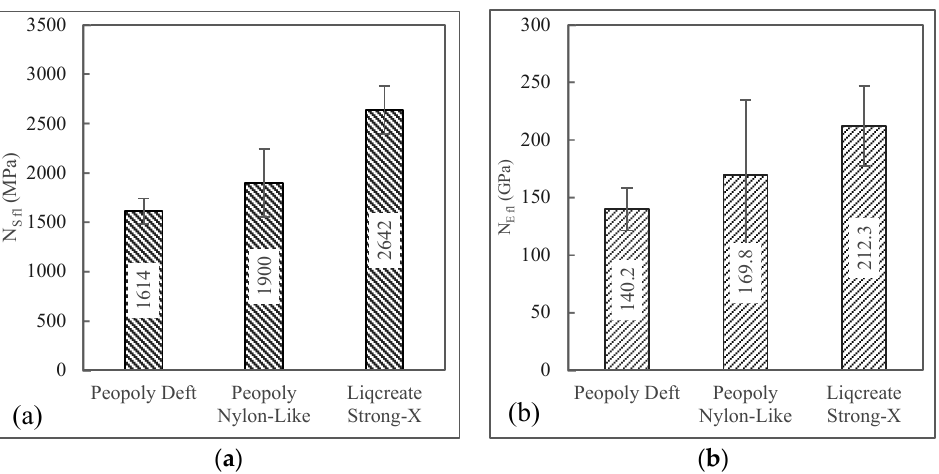
Figure 14. ( a ) Normalized flexural strength and ( b ) normalized flexural modulus.